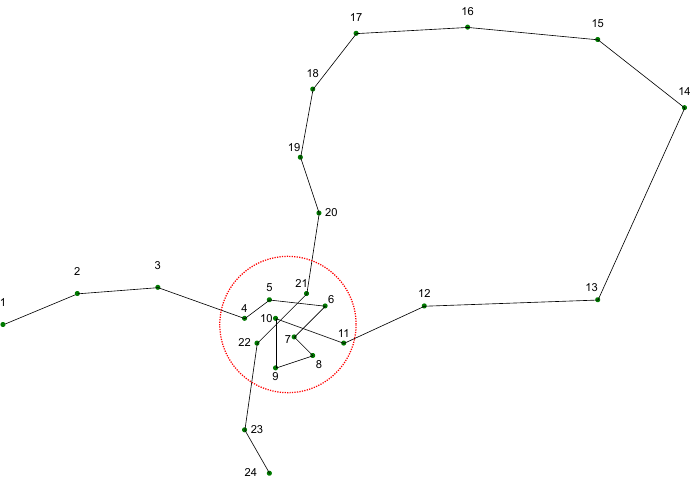
Figure 3. An example of temporal non-continuous points in cluster